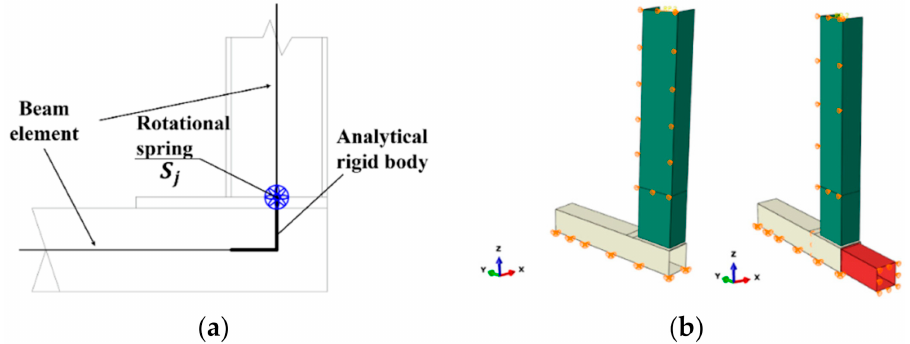
Figure 41. Finite element model of intramodule connection for validation. ( a ) Simplified finite element model; ( b ) Refined finite element